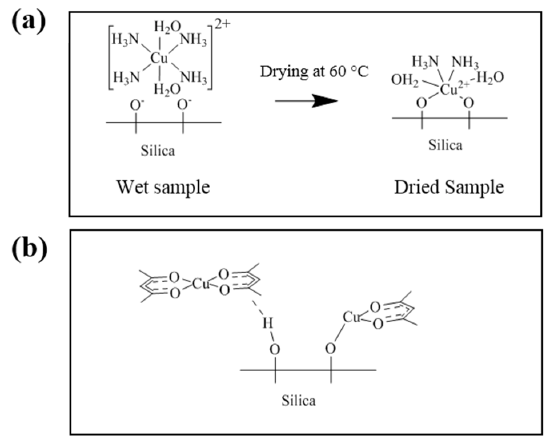
Figure 6. Interactions between Cu 2+ species and silica during and after the impregnation for ( a ) ADP method and ( b ) MDD method. (Figure 6a: reproduced with permission from Trouillet et al. [38]. Copyright Royal Society of Chemistry, 2000.)